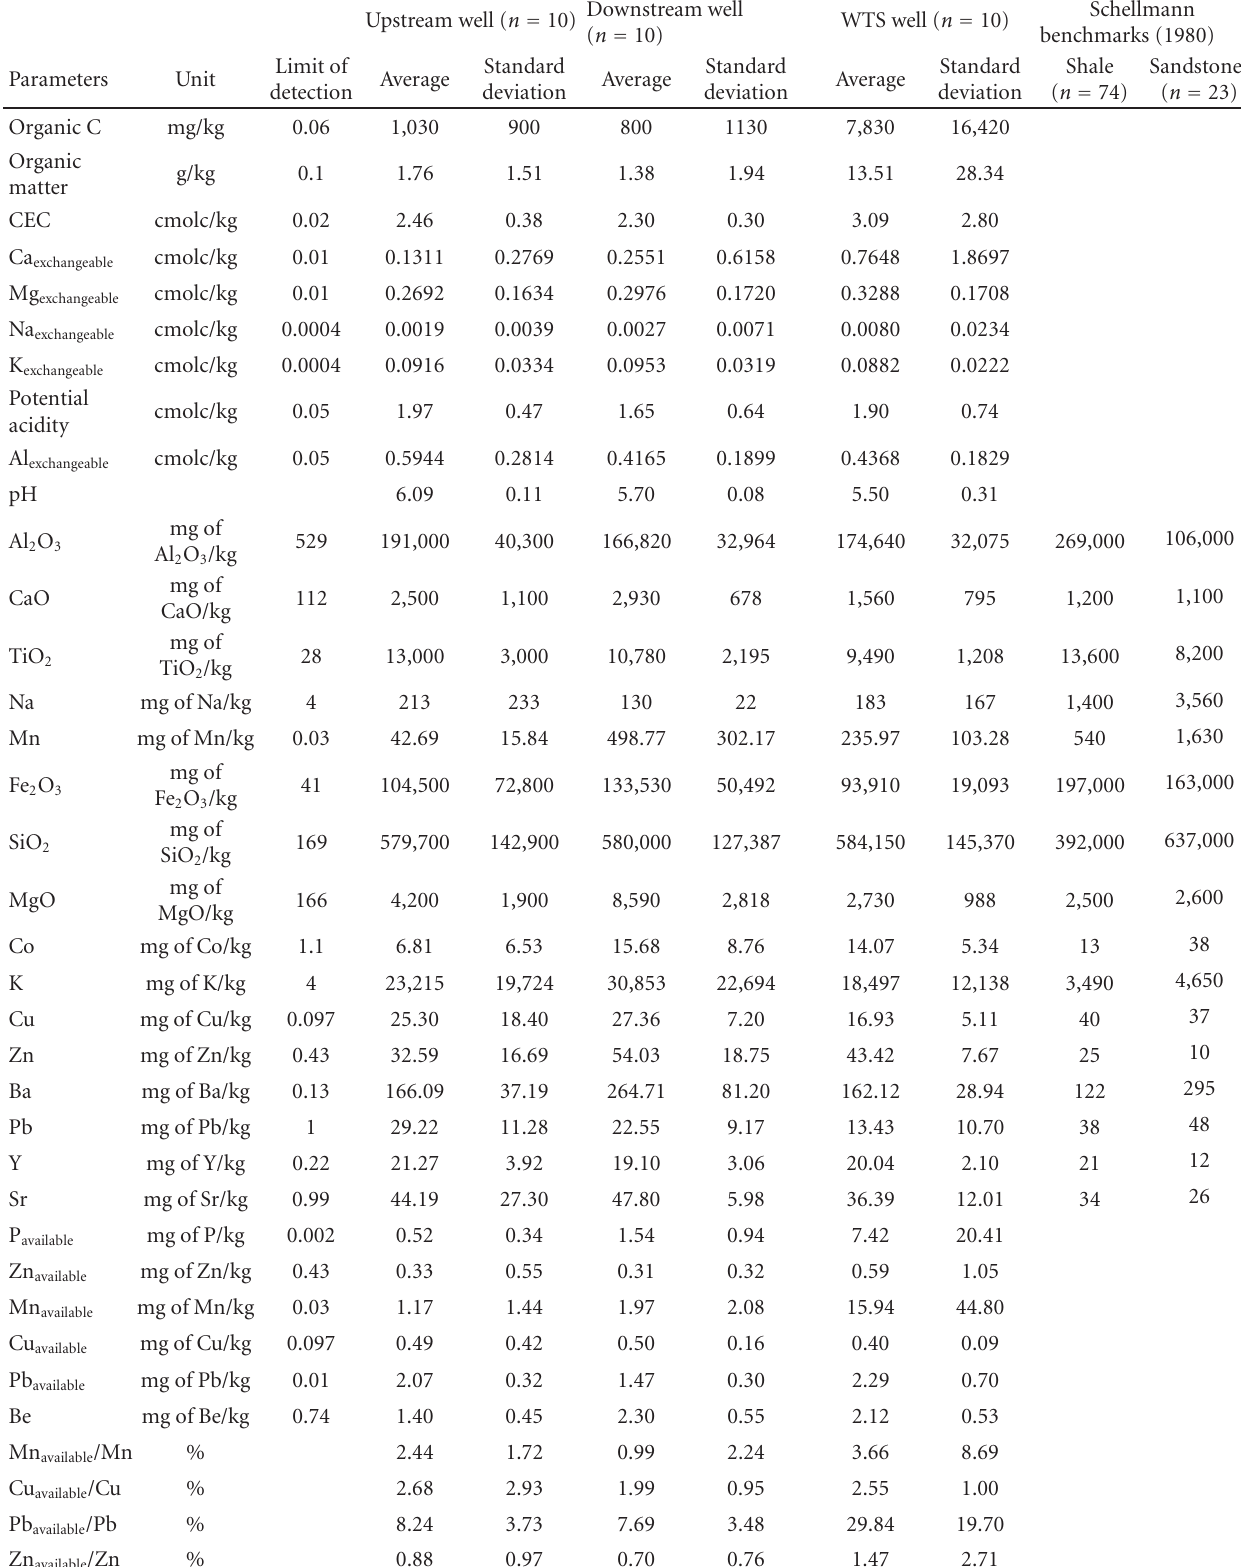
Table 2: Results of the chemical analysis of samples taken every three meters from the drilling